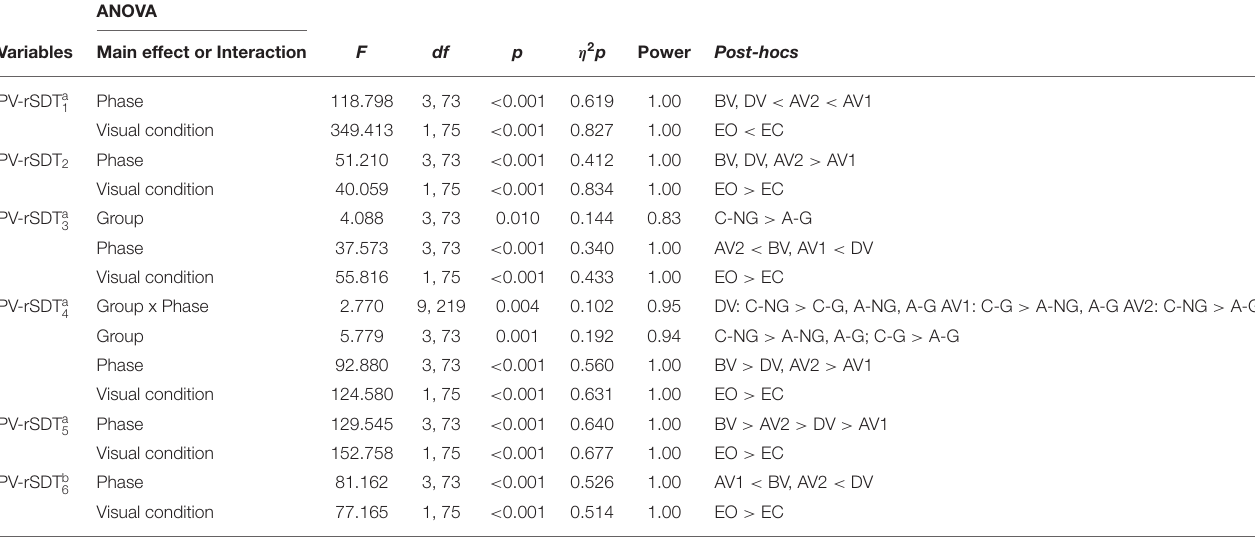
TABLE 3 | Significant results from the four (Group) x four (Phase) x two (Visual condition) ANOVAs in the principal velocities (PV).